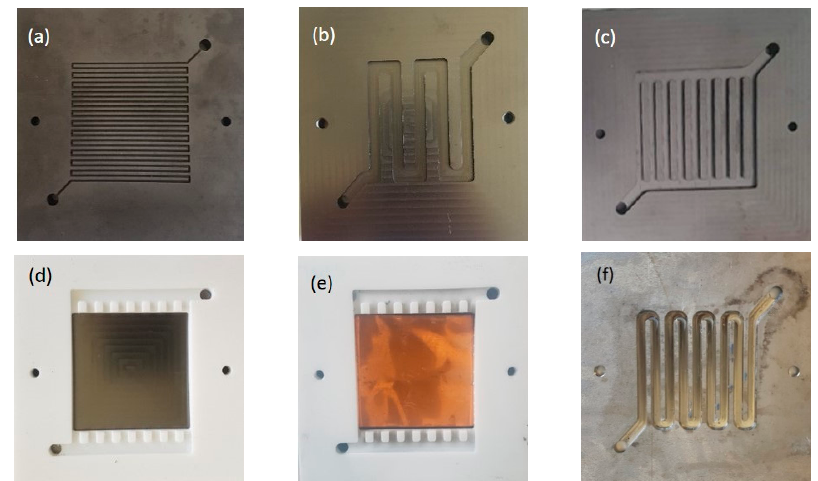
Figure 1. Flow fields used in this study. For the positive electrode: ( a ) serpentine. For the negative electrode: ( b ) serpentine, ( c ) parallel, ( d ) flow frame, ( e ) copper-based flow frame, and ( f ) modified serpentine.